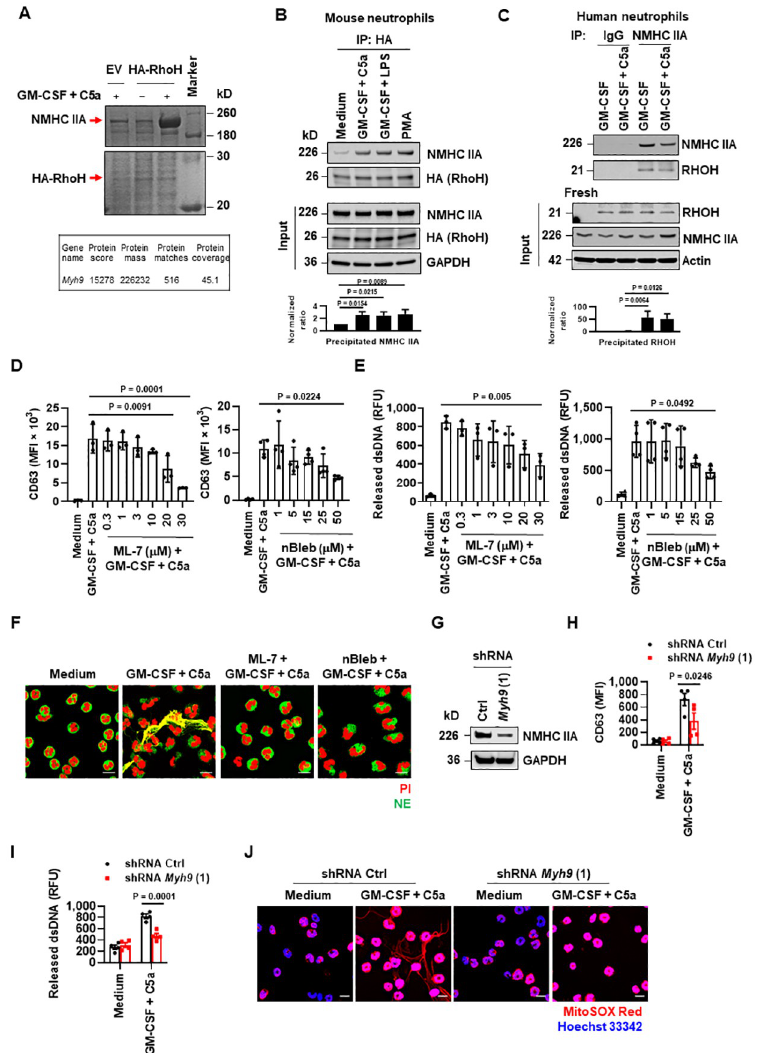
Fig 3. RhoH interacts with NMHC IIA. ( A ) Coomassie blue staining of HA pulldown proteins in HoxB8 neutrophils after stimulation with the indicated triggers. The proteins interacting with RhoH were identified by mass spectrometry analysis. ( B, C ) Immunoblot analysis after Co-IP with anti-HA antibody in Hoxb8 neutrophils ( B ) and anti-NMHC IIA antibody in human neutrophils ( C ). Quantification of the precipitated NMHC IIA ( B ) or RHOH ( C ) was shown below the representative images. ( D–F ) Pretreated human neutrophils with vehicle control or myosin IIA inhibitors for 30 min were subsequently activated with GM-CSF in combination with C5a. ( D ) Neutrophil degranulation was determined by flow cytometry. ( E ) Quantification of dsDNA released into the supernatants. ( F ) NET formation indicated by the colocalization of NE (green) with released DNA (PI, red) was analyzed by confocal microscopy. Scale bars, 10 μ m. ( G ) Protein expression of NMHC IIA in mature HoxB8 neutrophils treated with control (Ctrl) or Myh9 shRNA was analyzed by immunoblot. ( H , I ) Mature HoxB8 neutrophils were treated as indicated. ( H ) Neutrophil degranulation was determined by flow cytometry. ( I ) Quantification of released dsDNA in culture supernatants. ( J ) Extracellular DNA fibers were analyzed by confocal microscopy. Scale bars, 10 μ m. ( A–C, F, G, J ) Three independent experiments were performed. ( B–E, H, I ) Values represent means ± SD. ( B–E ) One-way ANOVA with Dunnett’s multiple comparisons test. ( H, I ) Two-way ANOVA with Sˇı´da´k’s multiple comparisons test. The underlying numerical data for Fig 3B–E, 3H, and 3I can be found in S1 Data. The uncropped immunoblots for Fig 3A–C and 3G can be found in S1 Raw images. Co-IP, co-immunoprecipitation; dsDNA, double-stranded DNA; GM-CSF, granulocyte/ macrophage colony-stimulating factor; NE, neutrophil elastase; NET, neutrophil extracellular trap; NMHC IIA, non- muscle myosin heavy chain IIA; PI, propidium iodide.